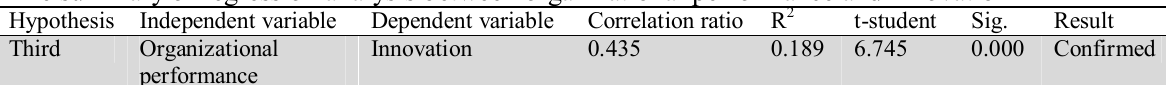
The summary of regression analysis between organizational performance and innovation Hypothesis Independent variable